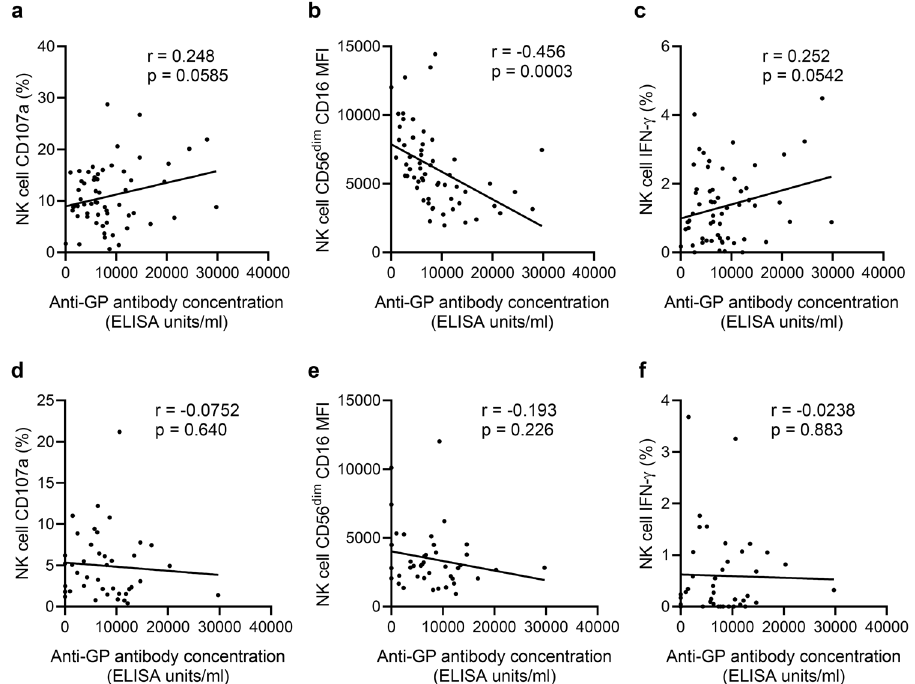
Fig. 7 Correlation between vaccination-induced anti-GP antibody concentration and NK cell responses. PBMC from a single unvaccinated donor ( a – c ) or from individual study participants at visit 2 ( d , e ) were cultured with EBOV GP in the presence of serum collected from the trial individuals 14 days post-dose 2 (visit 2). NK cell CD107a ( a , d ), CD16 MFI ( b , e ), and IFN- γ ( c , f ) expression was compared with anti-GP antibody concentration (measured at visit 2) (ELISA units/ml; determined previously 38 (see Table 1 for number of participants). Goodness-of- fi t line